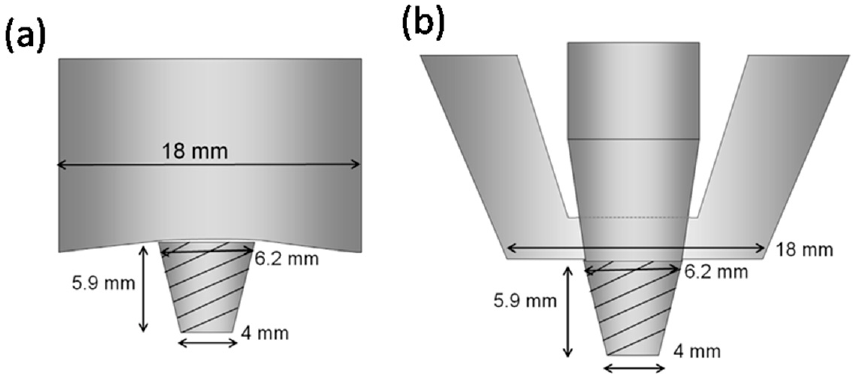
Figure 13. Schematic drawings of the di ff erent FSW tools: ( a ) the conventional FSW tool and ( b ) the SSFSW tools used by Wu et al. in their investigation [118] (reprint with permission from Elsevier).